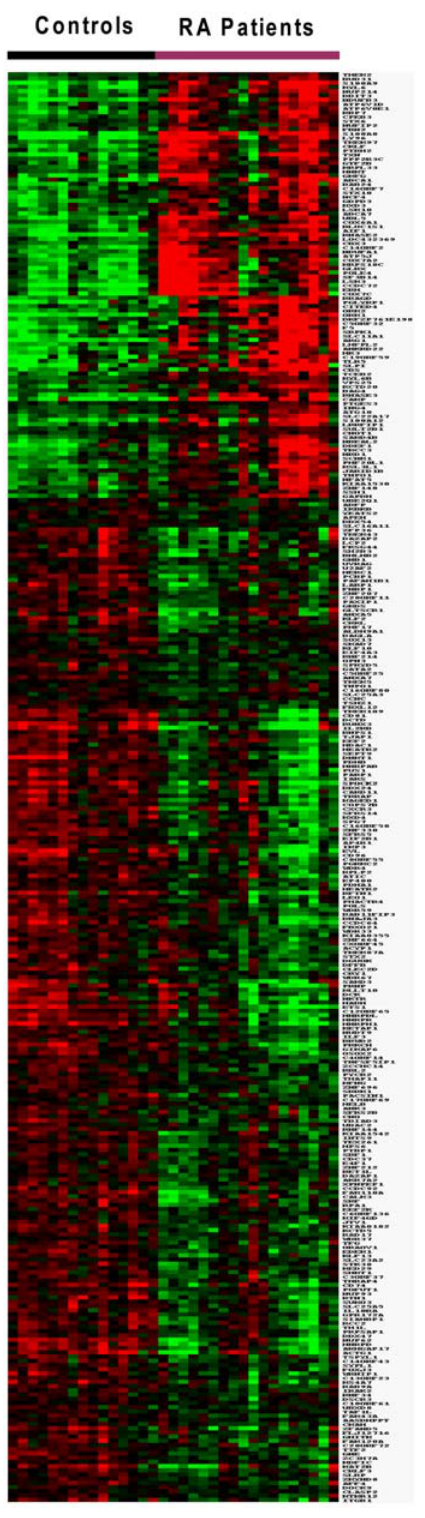
Figure 2. Cluster diagram of the expression of 339 significantly expressed genes in 18 RA patients and 15 controls. Genes are organizedbyhierarchicalclusteringbasedonoverall similarityinexpression patterns. Red represents relative expression greater than the median expression level across all samples, and green represents an expression level lower than the median. Black indicates intermediate expression.